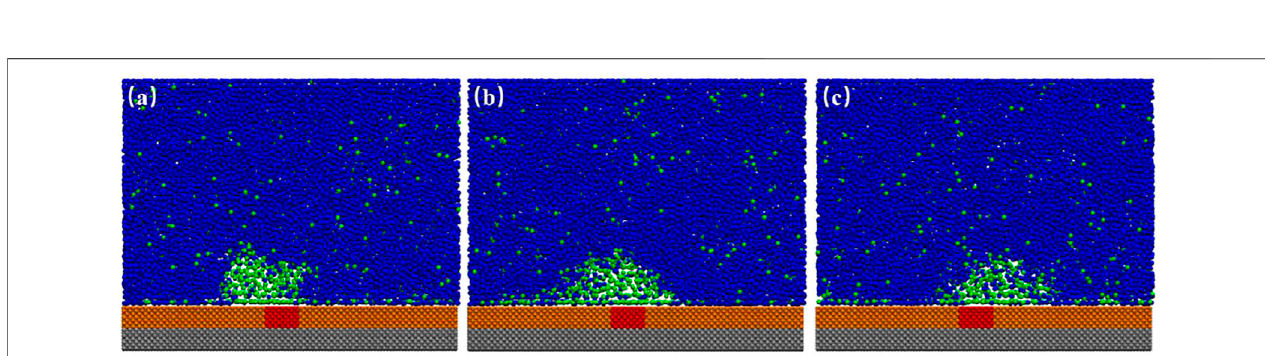
FIGURE 8 | Snapshots of INBs formed on S H patterned S M substrate. (A) Snapshot of 20.1 ns represents the receding contact line was pinned when INB was moving toward the left; (B) 22.6 ns. (C) Snapshot of 24.8 ns represents the receding contact line was pinned when INB was moving toward the right. In this case, 600 gas particles and 15,000 liquid particles were added in the simulation boxes with the typical size of 21.19 × 2.75 × 17.00 nm 3 . A movie for the process is available as Supplementary Video S2 .